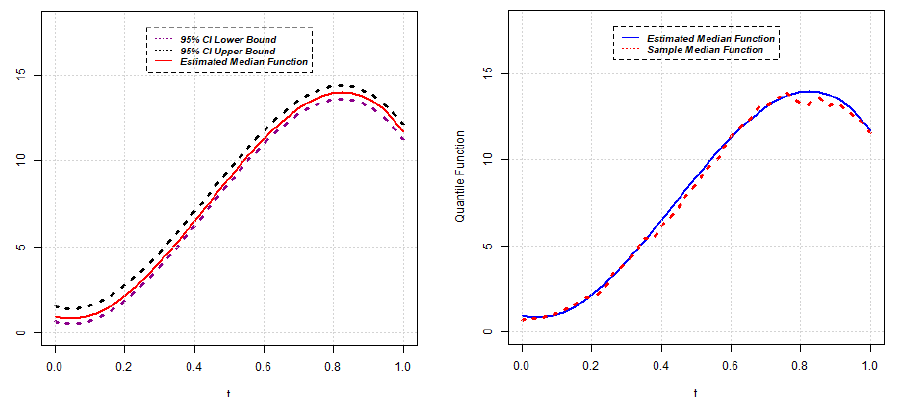
Figure 7. Estimated median function and C.I. ( left ); Estimated median and sample median ( right ) for Model